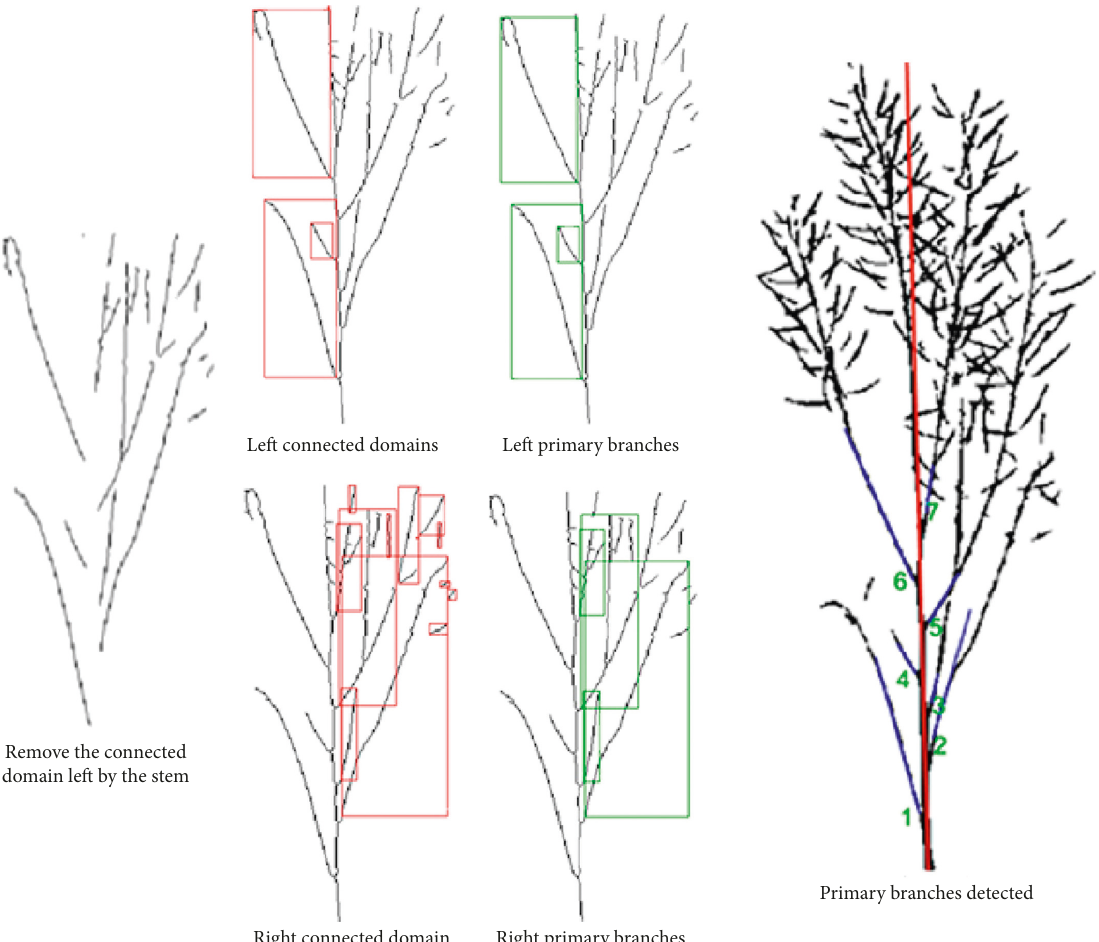
Figure 7: Detection of the connected domain of rapeseed’s primary